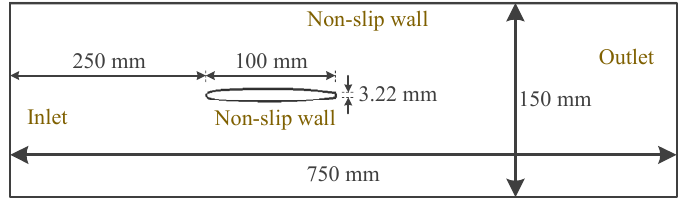
Figure 4. Computational domain and boundary conditions of NACA 0009 hydrofoil.